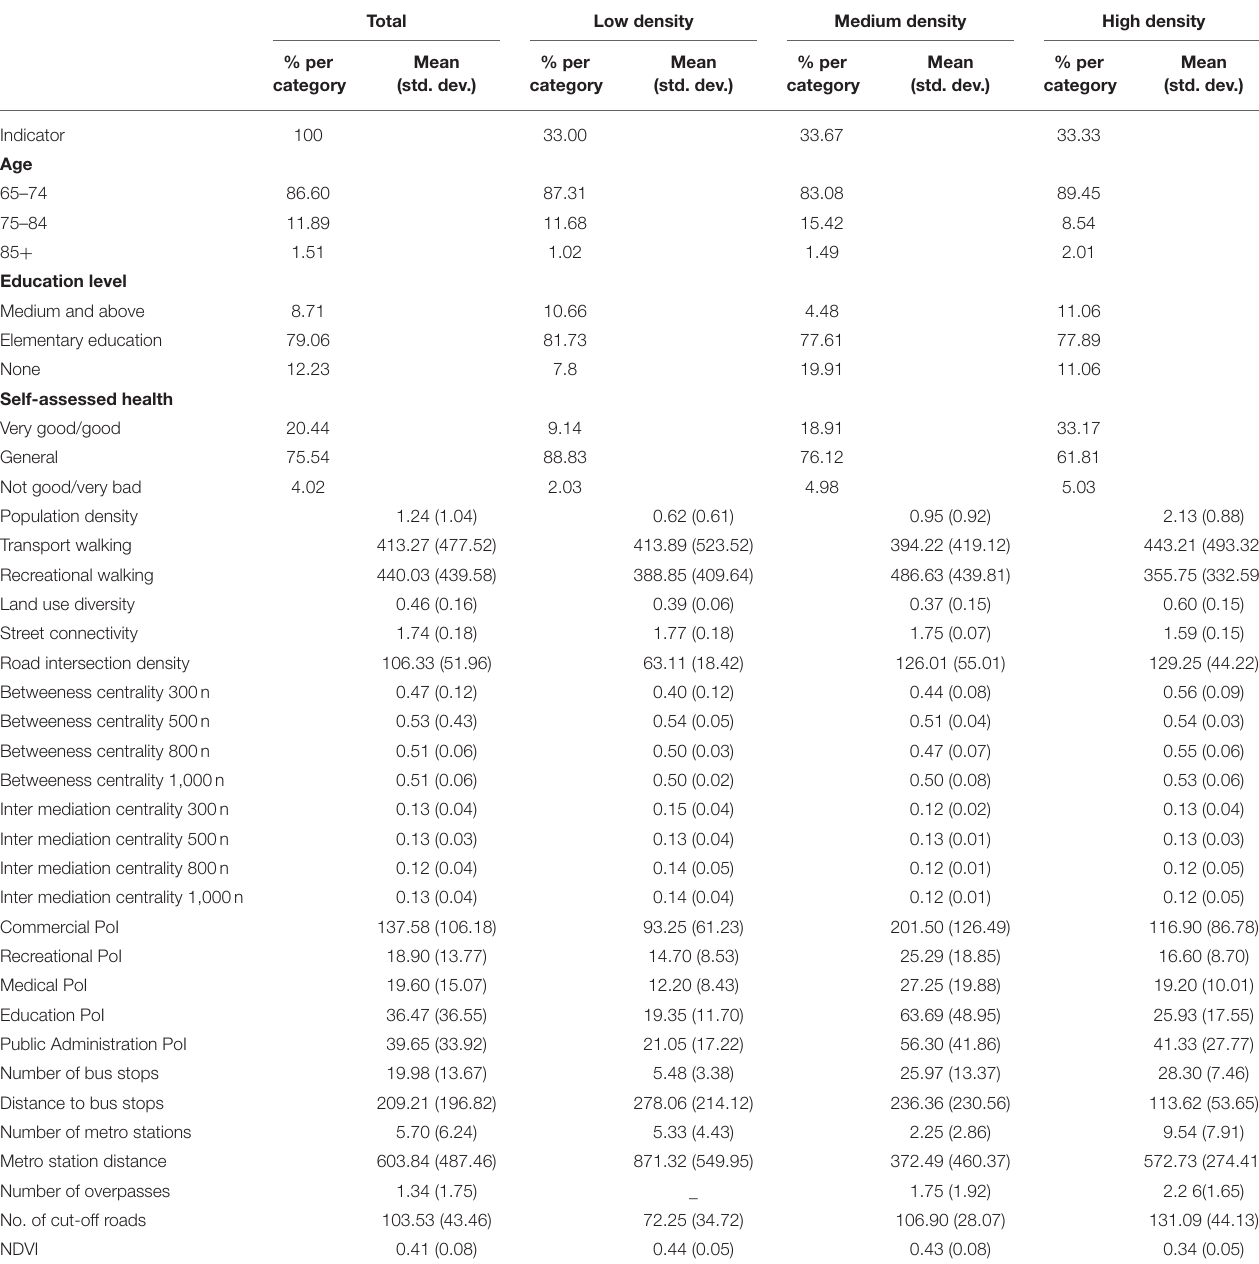
TABLE 3 | Descriptive statistics to study the characteristics of the population and the natural and built environment of the living environment ( n = 597).